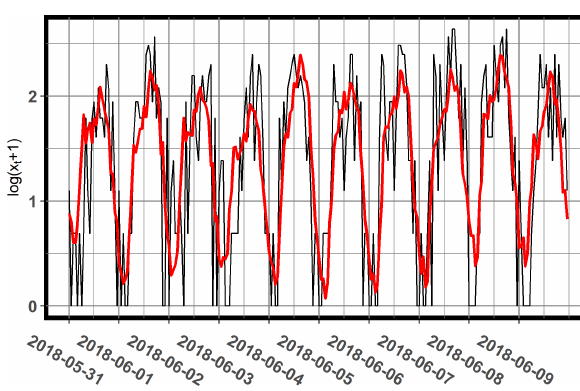
Additionally, the Kolmogorov-Smirnov residual nor- mality test was performed. Value of the test statistics D is 0.035 and p-value is 7.46 · 10 −10 . This means that, at the significance level of 0.01, the working hypothesis should be rejected in favour of the alternative hypothesis. We also Figure 9: Empirical values and Holt-Winters model fitted